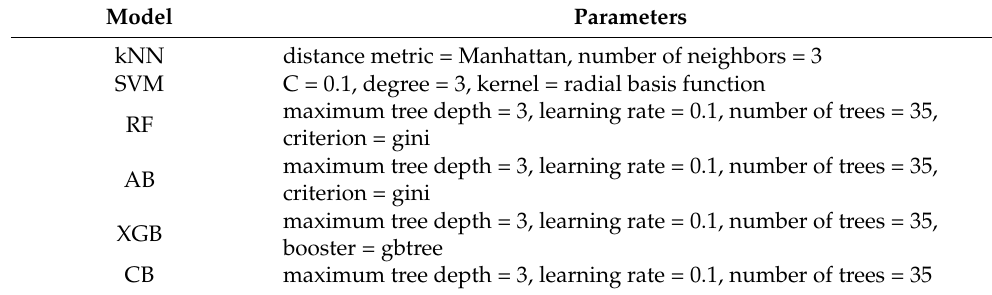
Table 4. Classifier_B